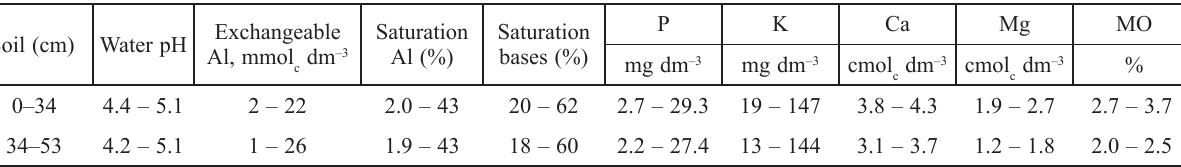
Table 2 – Characteristics of DRL soil from Jundiaí, São Paulo, sampled at depths of 0–34 and 34–53 cm from the surface Soil (cm) Water